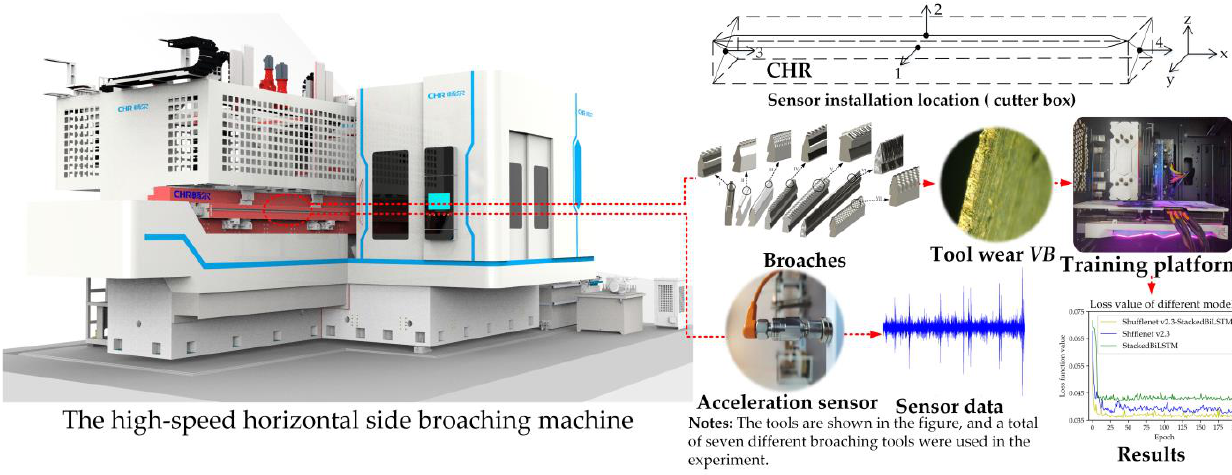
Figure 5. Test device diagram of tool wear experiment. Table 3. Main parameters of horizontal broaching machine LG6516zx-2800 .